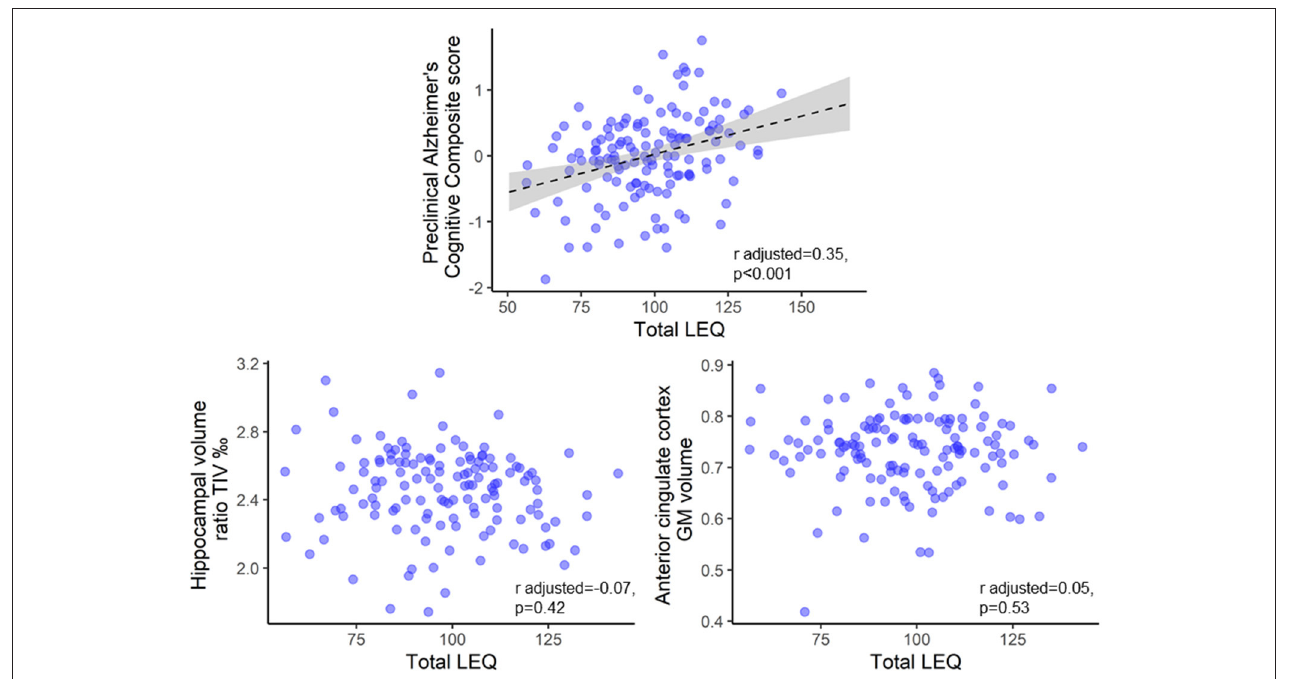
FIGURE 3 | Brain and cognitive associations: scatterplot of total LEQ and the Pre-clinical Alzheimer’s Cognitive Composite, the grey matter volumes of the hippocampus, and the anterior cingulate cortex at baseline. Raw data (i.e., unadjusted for age and sex) are plotted. Statistical values were adjusted for age and sex. Please note that these analyses were performed in the French Age-well sub-sample because of data availability ( n = 135). GM, grey matter; TIV, Total Intracranial Volume.